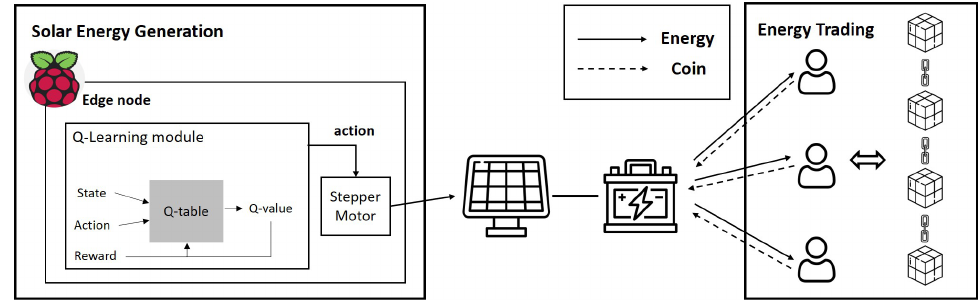
Figure 1. System